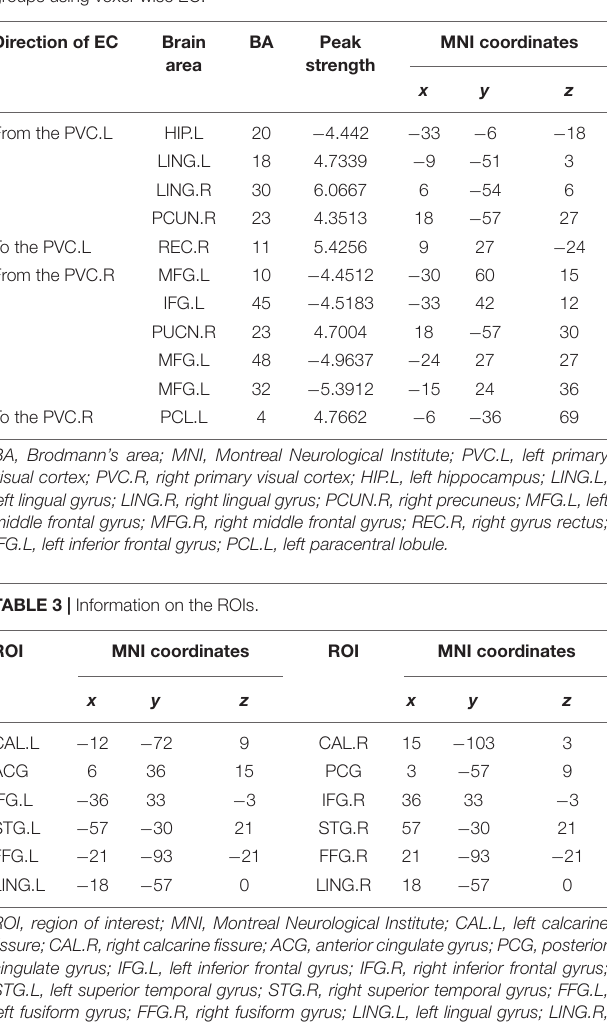
TABLE 2 | Voxel coordinates with the significant EC value between the two groups using voxel-wise